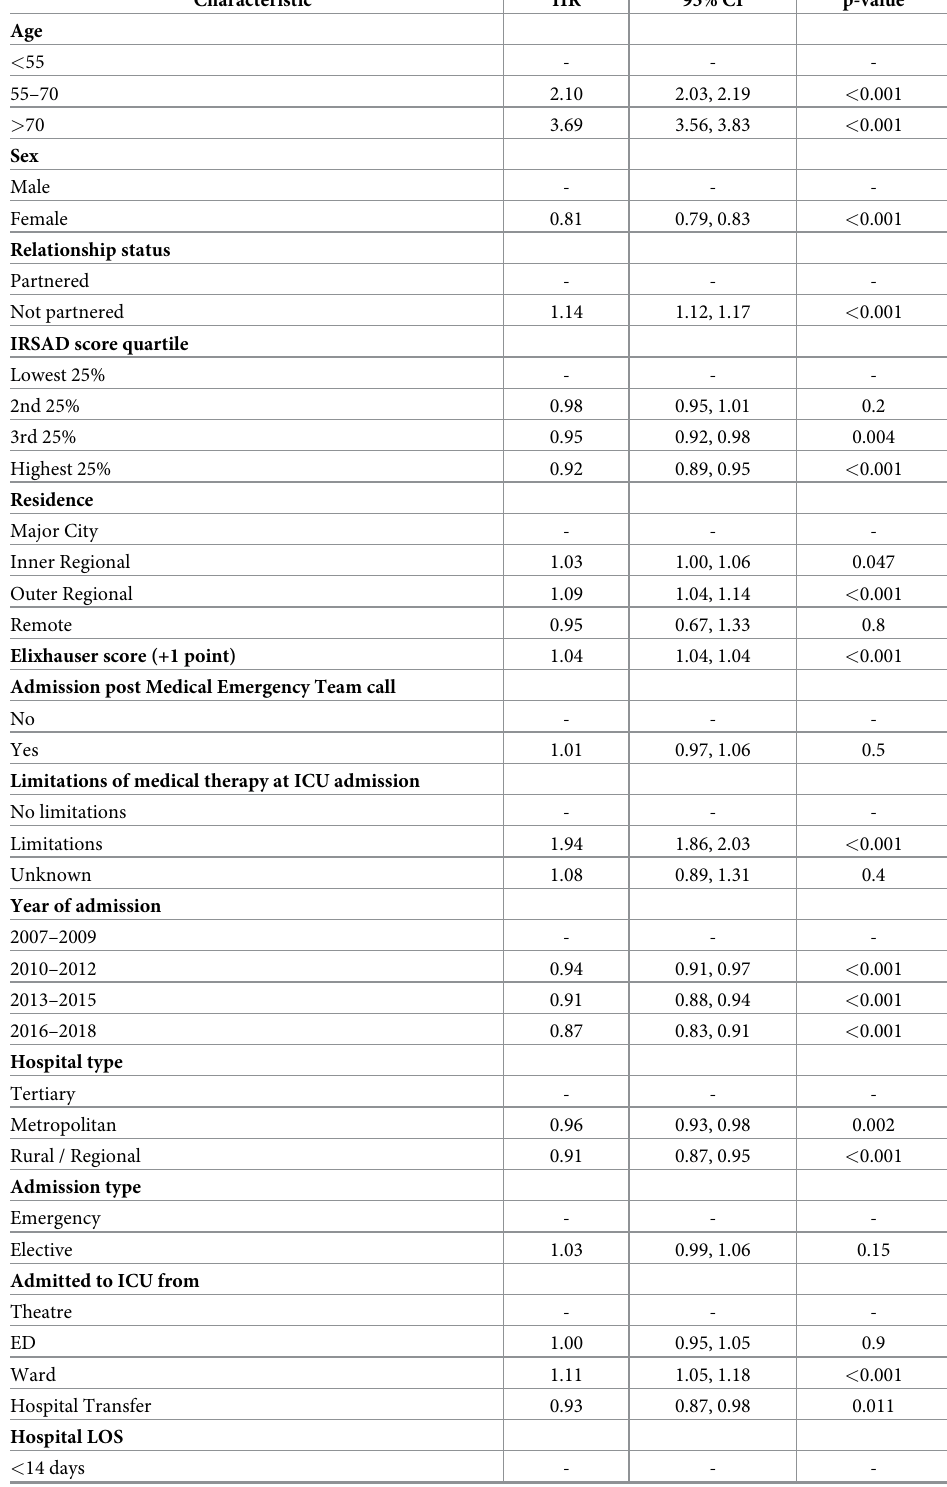
Table 2. Multivariate Cox regression for long-term mortality hazard. (N =